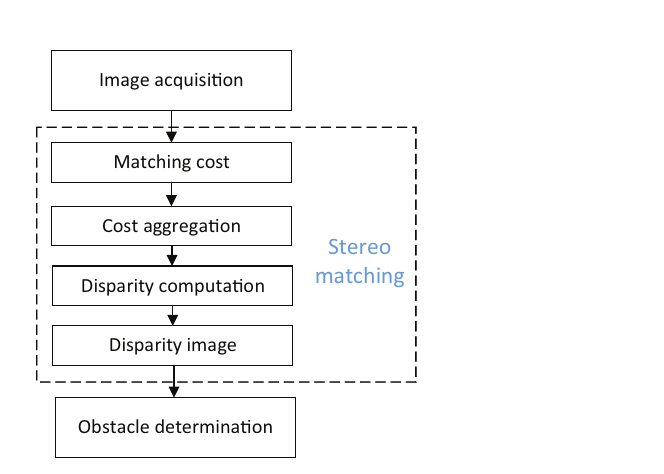
Figure 10. Binocular visual obstacle detection flow chart.